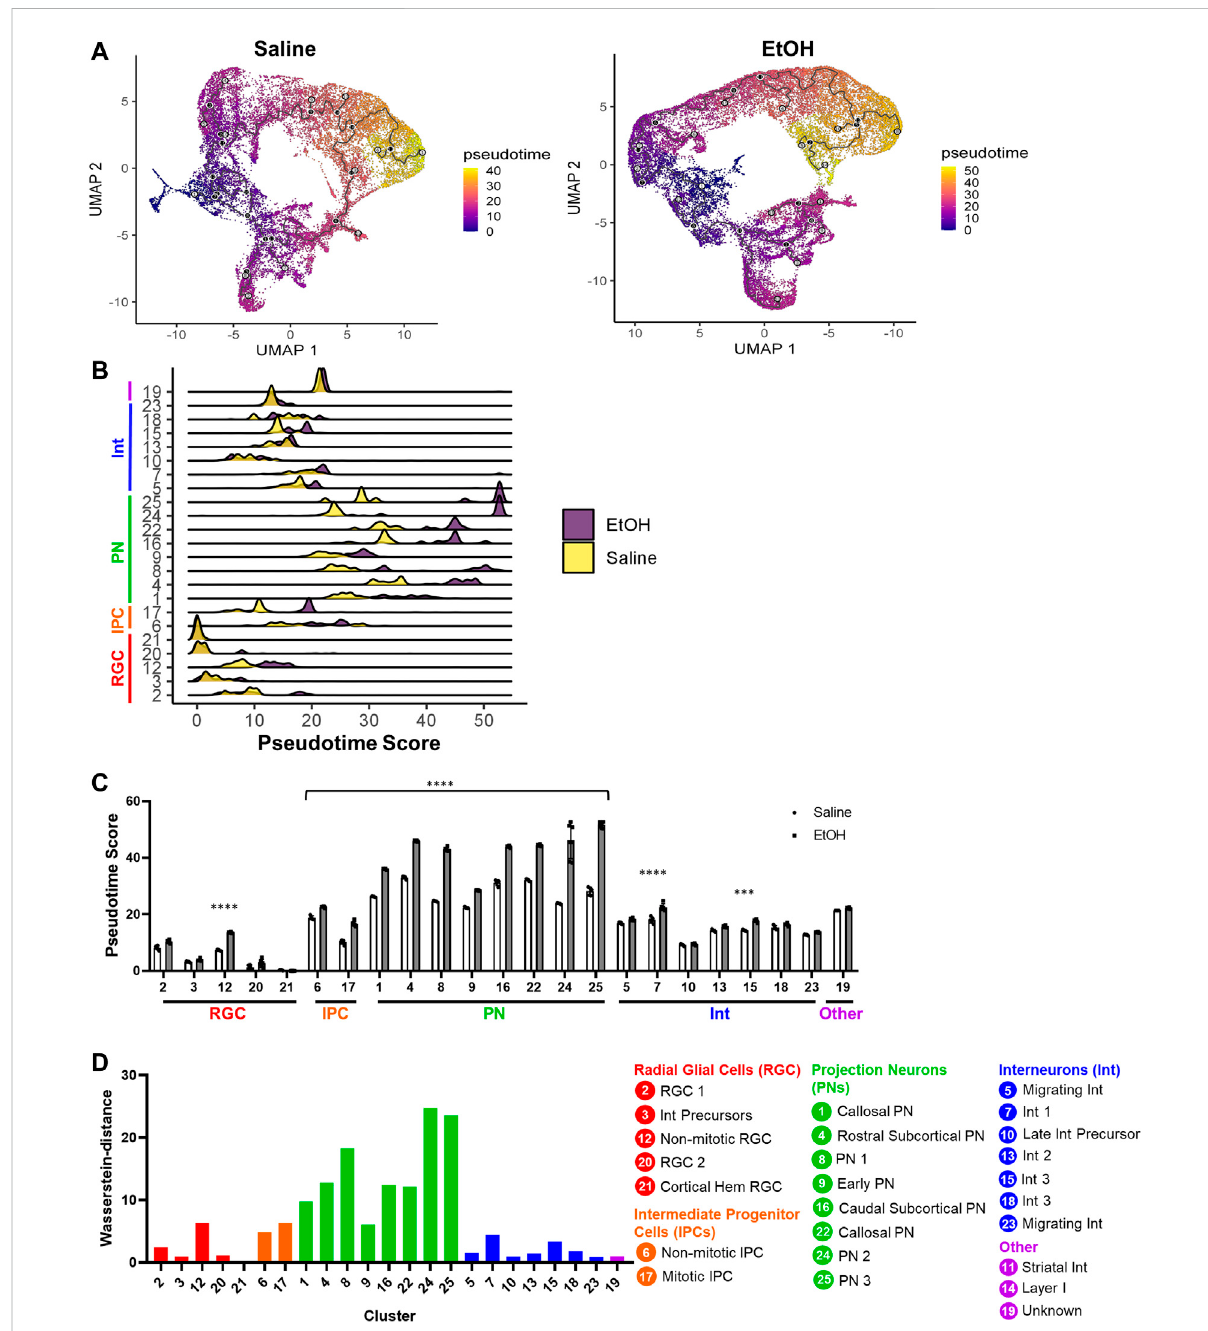
FIGURE 4 Pseudotime analysis of cell differentiation trajectories. (A) Individual UMAPs for Saline and EtOH overlaid with color representative of pseudotime scores for each cell. (B) Bridge plot of the pseudotime score distribution for cells within each cluster. (C) Bar graph of the average pseudotime score for each cell type comparing Saline and EtOH. (D) Wasserstein-distance between the distribution of Saline and EtOH pseudotime scores for each cluster. ***: p < 0.001. ****: p <